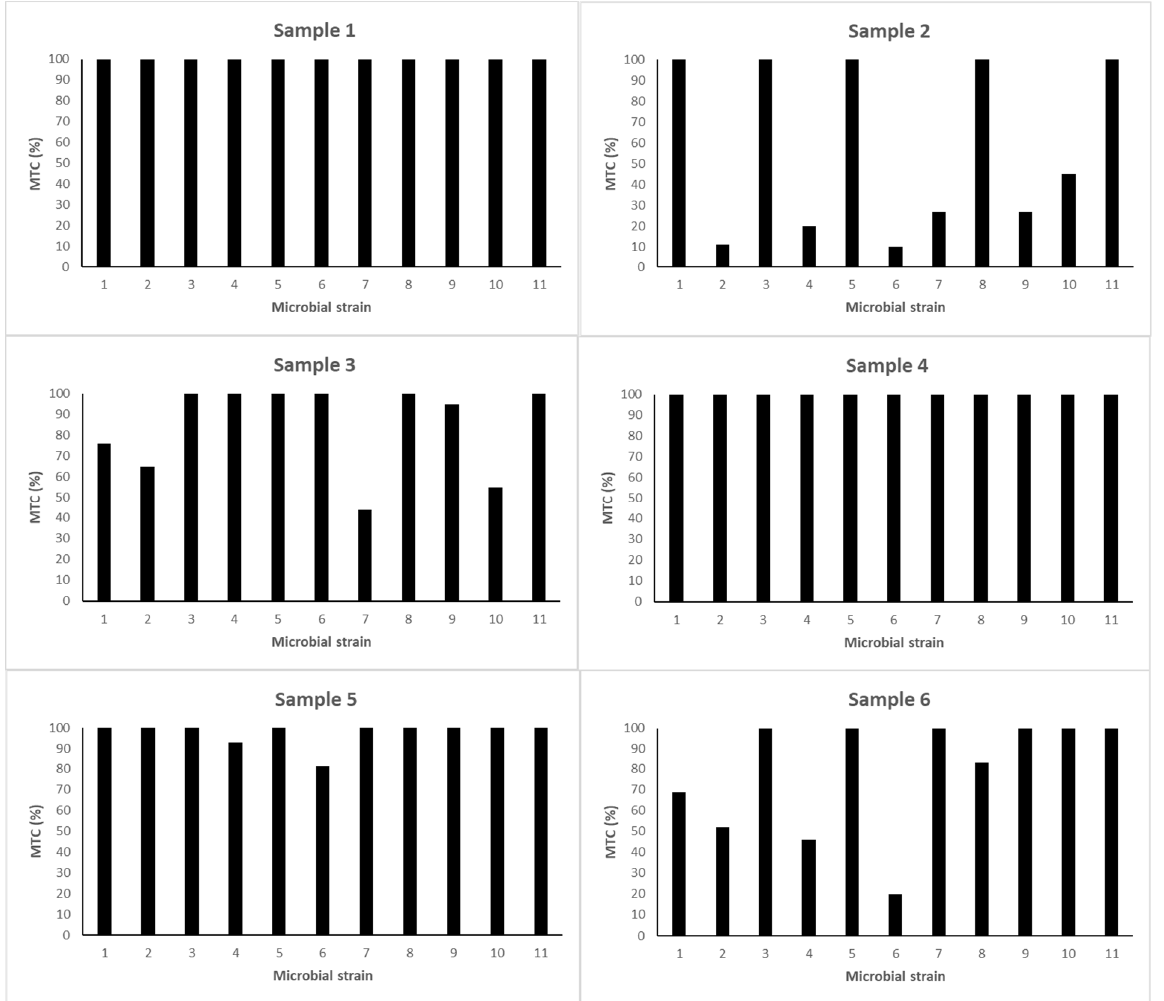
Figure 4. MTC value of six mushrooms tested for each strain, strain with y-axis 100%, indicates the MTC value above maximum concentration (description of 1–11—see Table 1).